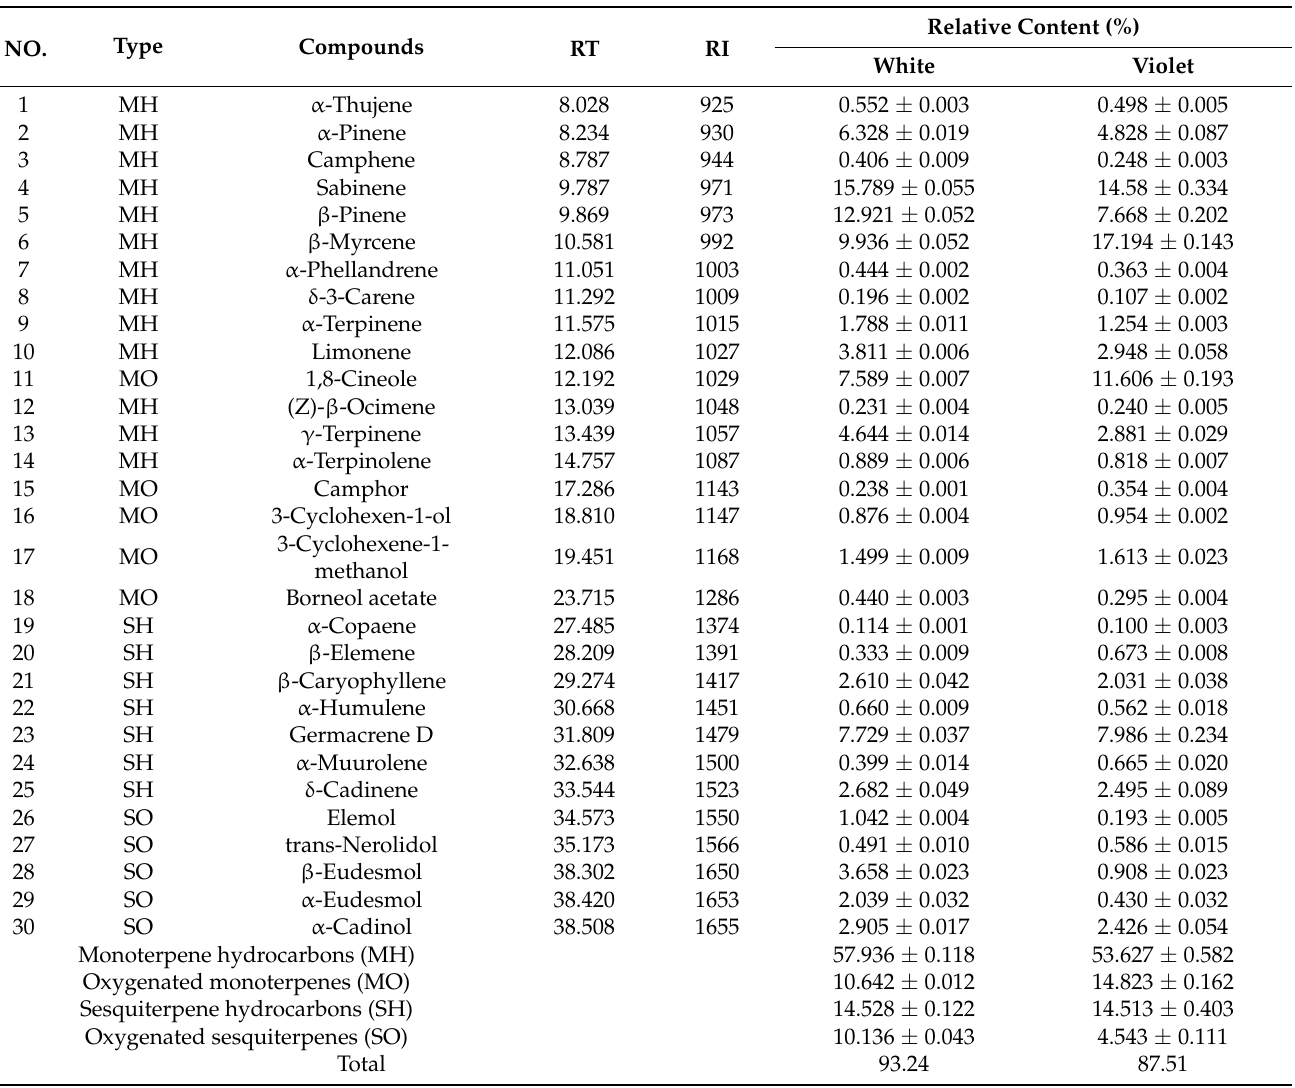
Table 1. Essential oil chemical compositions of M. heptapeta (white) and M. denudata var. purpurascens (violet) flower